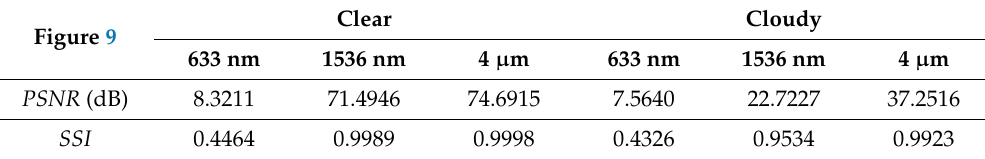
Table 5. Quantitative comparison of recovered images for Figure